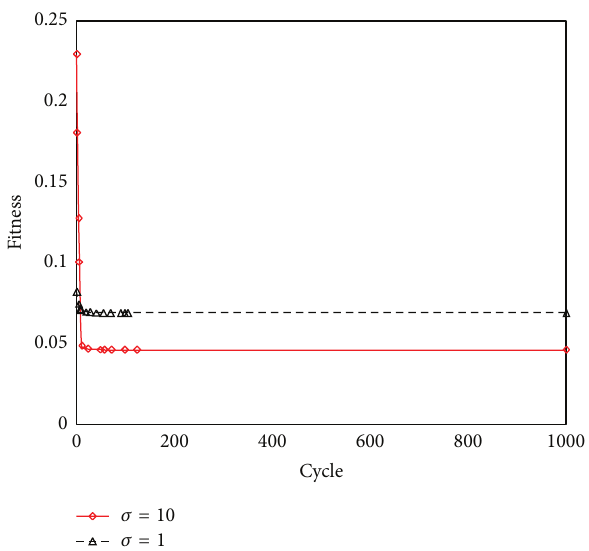
Figure 14: Fitness with different parameters of kernel function.